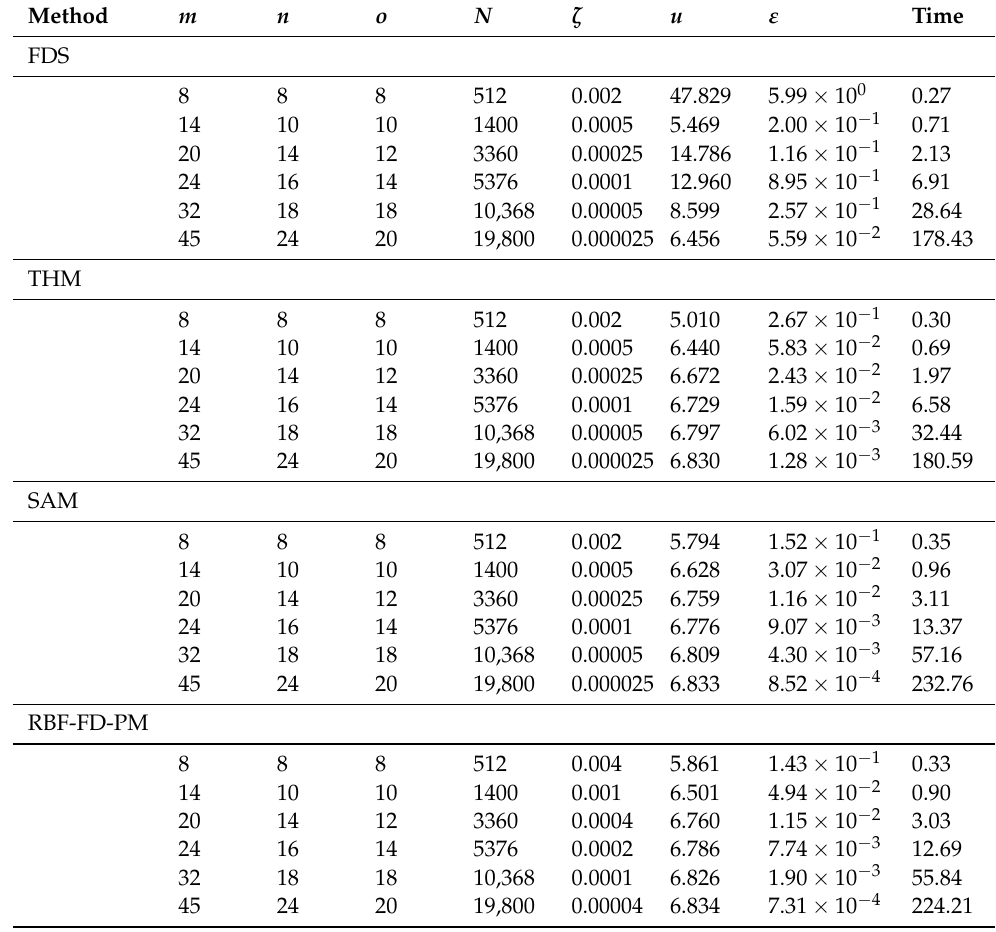
Table 3. Computational results and comparisons for the Case II.